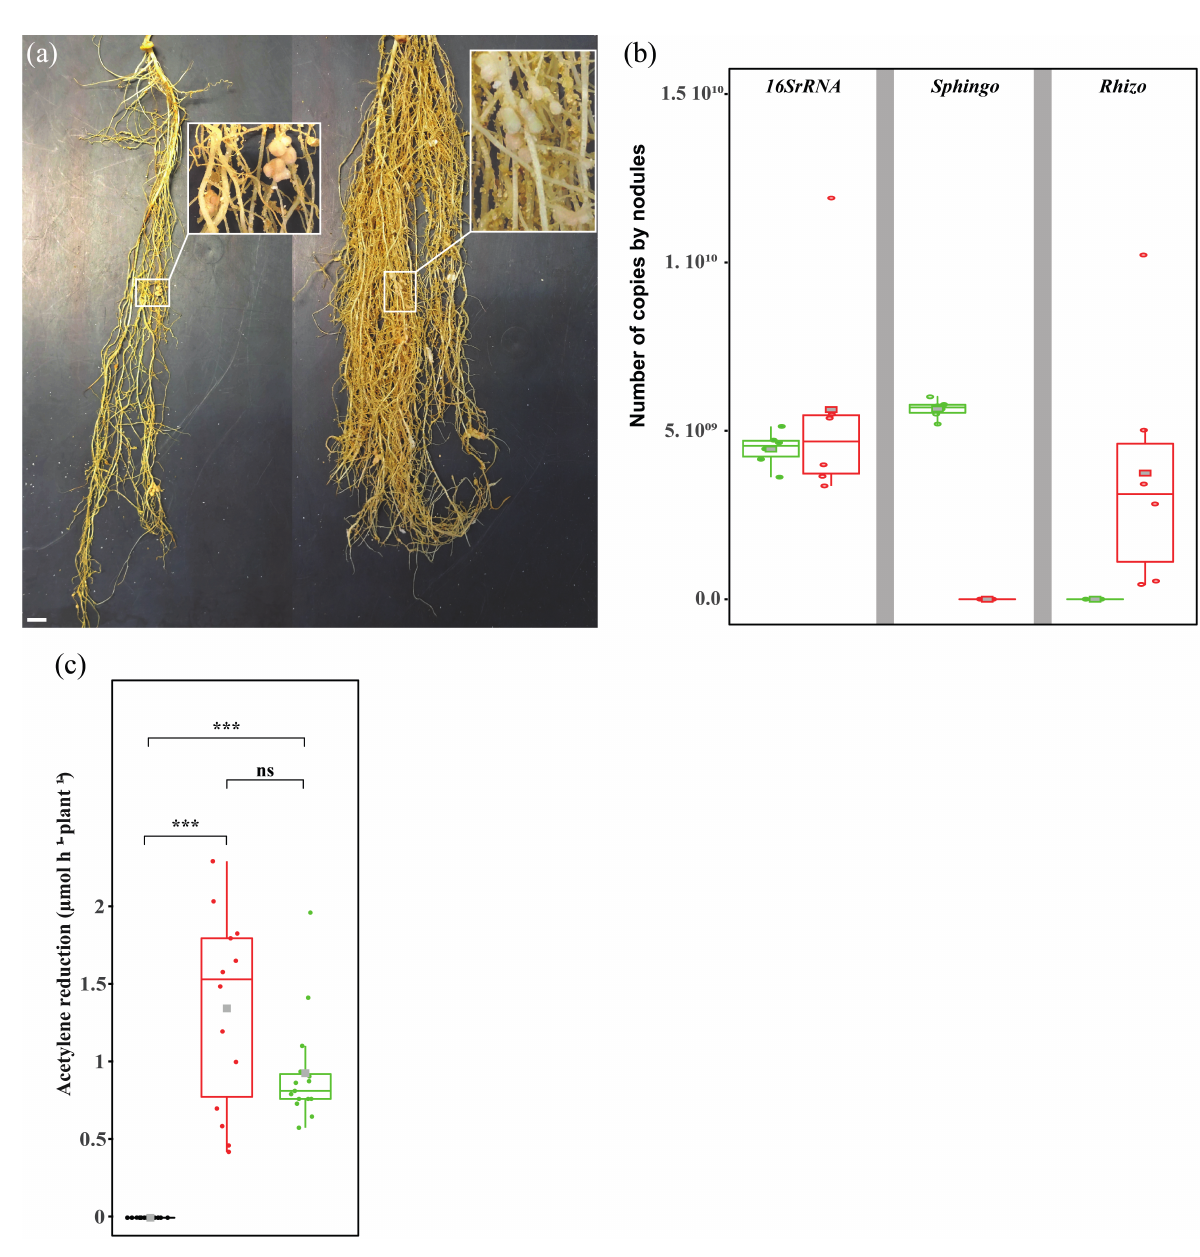
Figure 2. Characteristics of nodules. ( a ) The picture shows the presence of root nodules in plants inoculated with Rhizobium leguminosarum ( left ) and Sphingomonas sediminicola ( right ) grown under N-limited conditions. Scale = 1 cm. ( b ) Number of copies of the universal 16SrRNA as well as Sphingomonas and Rhizobium genes in nodules of pea plants inoculated with S. sediminicola (green) and R. leguminosarum (red). ( c ) Measured nitrogenase activity using the ARA with the noninoculated and non-nodulating root system (black) of pea plants, as well as the nodulated root system of peas inoculated with R. leguminosarum (red) and S. sediminicola (green). Statistical differences were based on Wilcoxon rank sum tests with Holm’s p -adjust. ***, p < 0.001; ns, not significant. 3.2. Sphingomonas sediminicola Genome Contains the Genetic Information Necessary to Induce Nodulation de novo whole-genome sequencing showed that S. sediminicola had a chromosome of 2,756,125 bp with a GC content of 62.88%. Thus, the genome coverage of the differ- ent sequencing runs ranged from 165 to 260X. The bacterial genome was composed of 2764 complete coding sequences (CDSs) and 64 tRNA sequences (Figure 3a). The